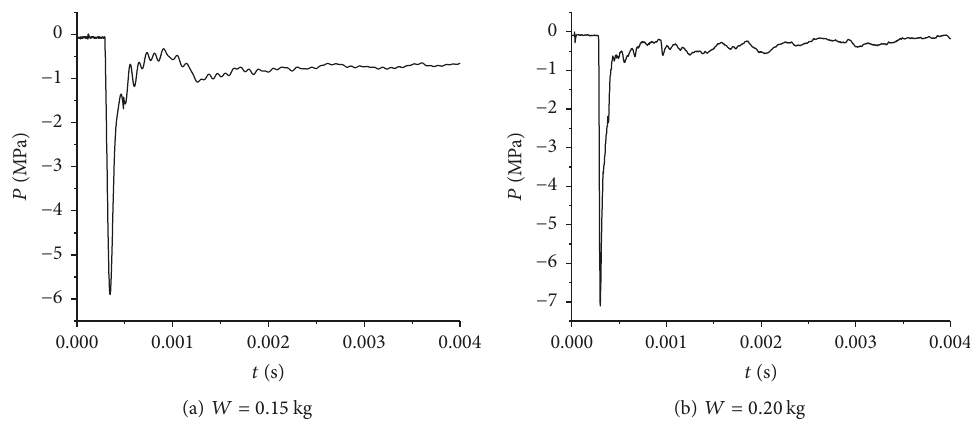
Figure 11: The time curve of the explosive shockwave of Model 1 at